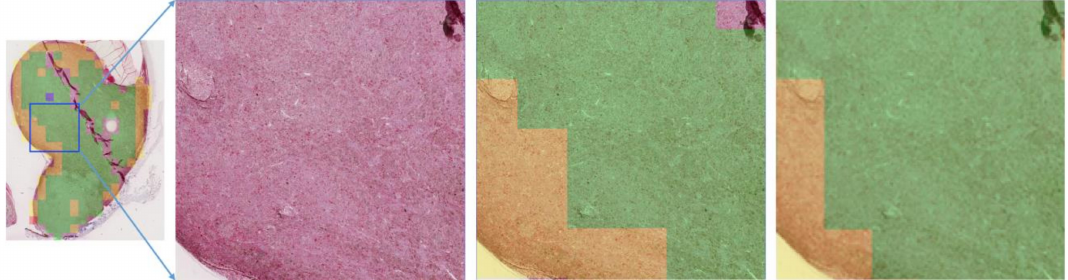
Figure 8. Prediction of BAP1 classification with our network in one detailed area of interest. ( Left ) Overview of the specimen with a “collar button” configuration. ( Middle left ) Original image of the region outlined in the blue box. ( Middle right ) Annotation by ophthalmic pathologist. ( Right ) Prediction by our network. Yellow areas correspond to BAP1-classification “high” and green to